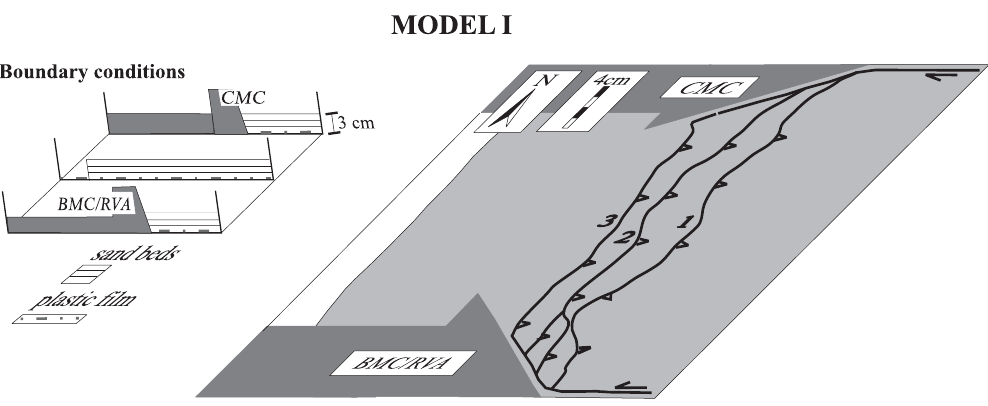
Fig. 3 – Plan-view line drawing of model I at the final stage of 22% (8 cm) shortening showing the slightly rounded, trapezoidal thrust traces. Numbers 1 to 3 indicate the order of fault formation. CMC – Caetés Metamorphic Complex; BMC/RVA – Bação Metamorphic Complex/Rio das Velhas Arch.